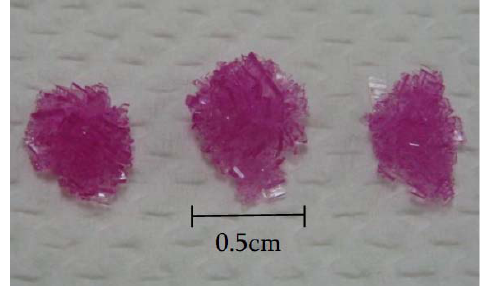
Figure 1. Example of crystals obtained after storage at 4–6 °C for 7